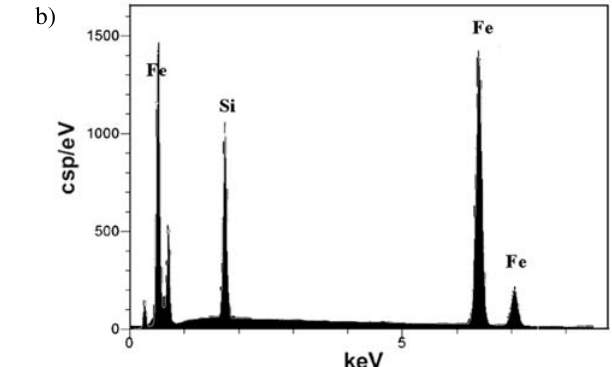
Figure 1. The EDX spectra of Fe